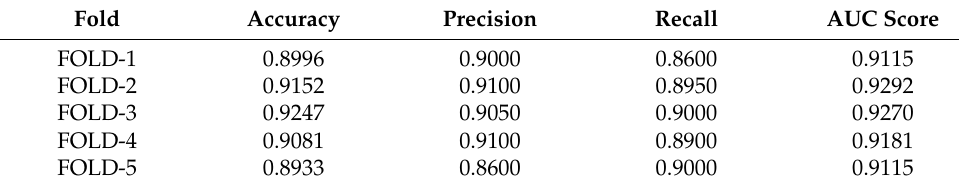
Table 7. The 5-fold cross validation results of the BreaKHis dataset. Fold